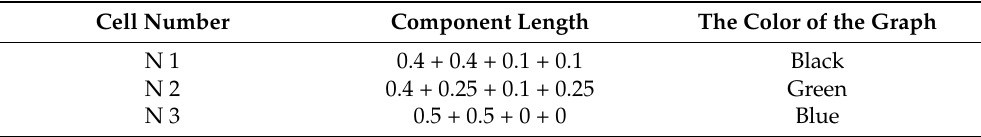
Table 1. Small perturbations of a monodisperse crystal. Description of the unit cell